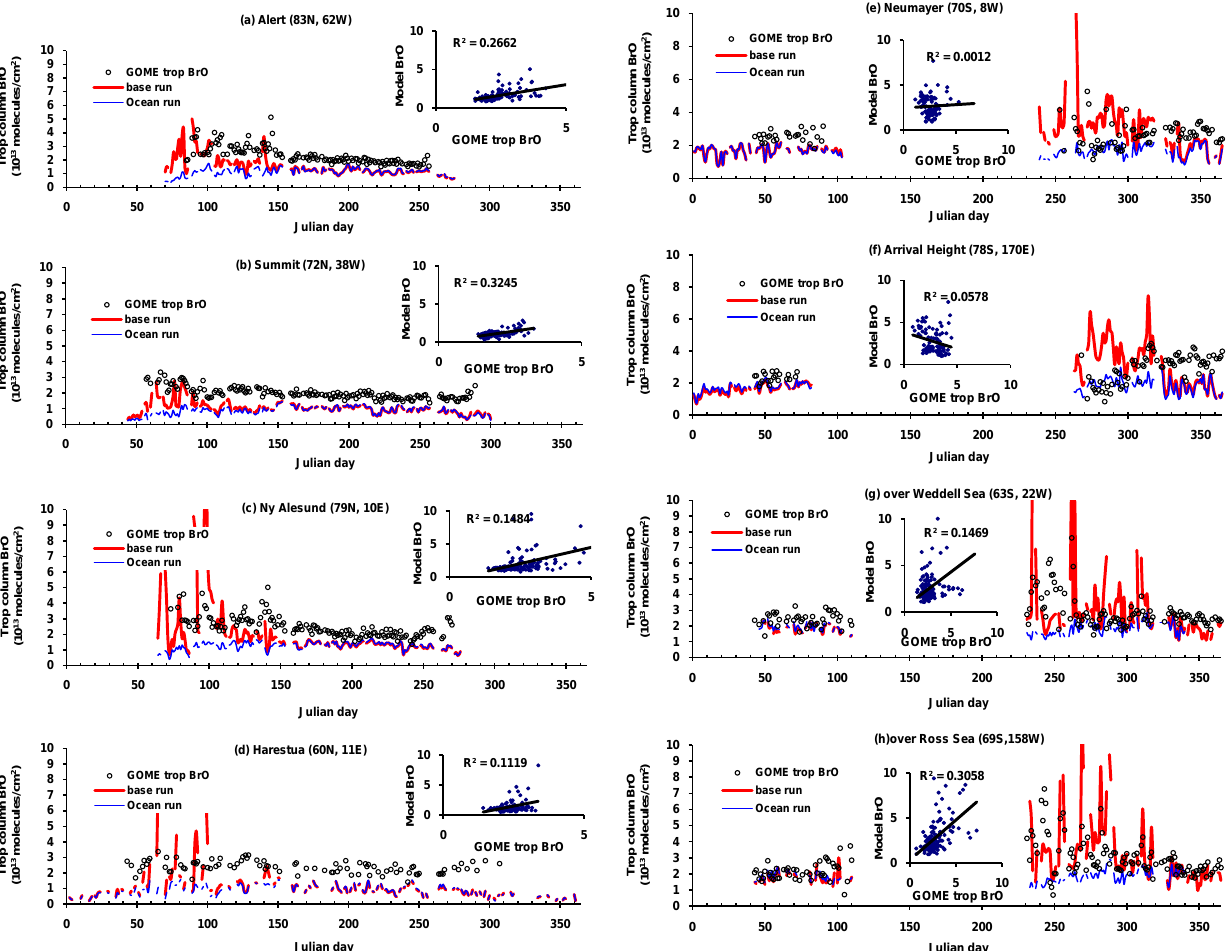
Fig. 4. Comparisons of modeled and retrieved tropospheric column BrO over 8 sites in the NH and SH polar region for year 1998. The inset plot shows the relationship and regression coefficient between the retrieved and modeled tropospheric BrO. The model results are from BASE